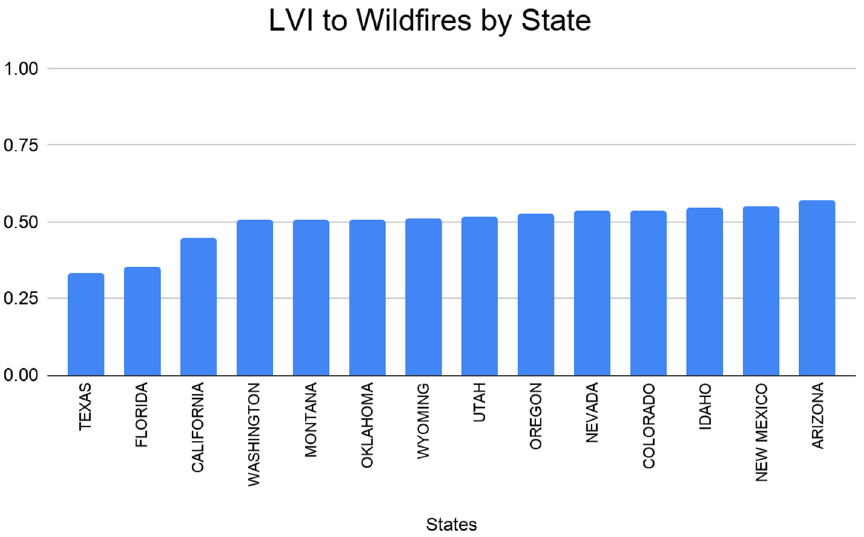
Figure 4. Histogram showing the LVI of the 14 selected states in the US with Arizona having the highest LVI and Texas having the lowest LVI.